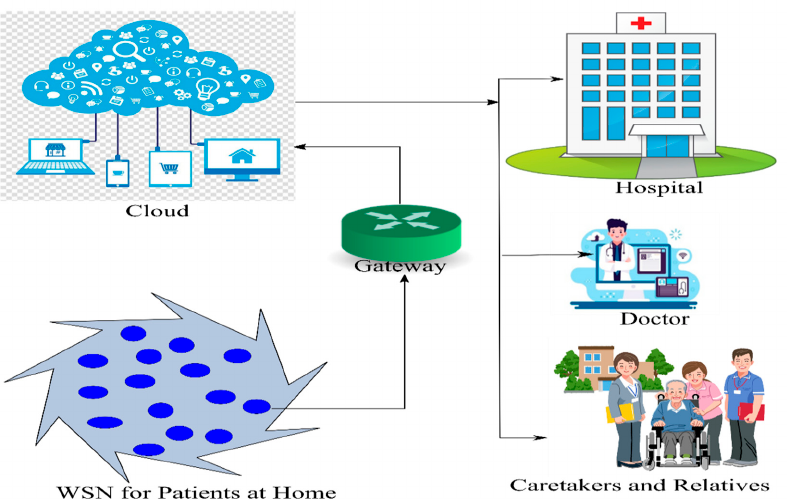
Figure 10. The proposed framework for integration of IoT with WSN for e-healthcare.